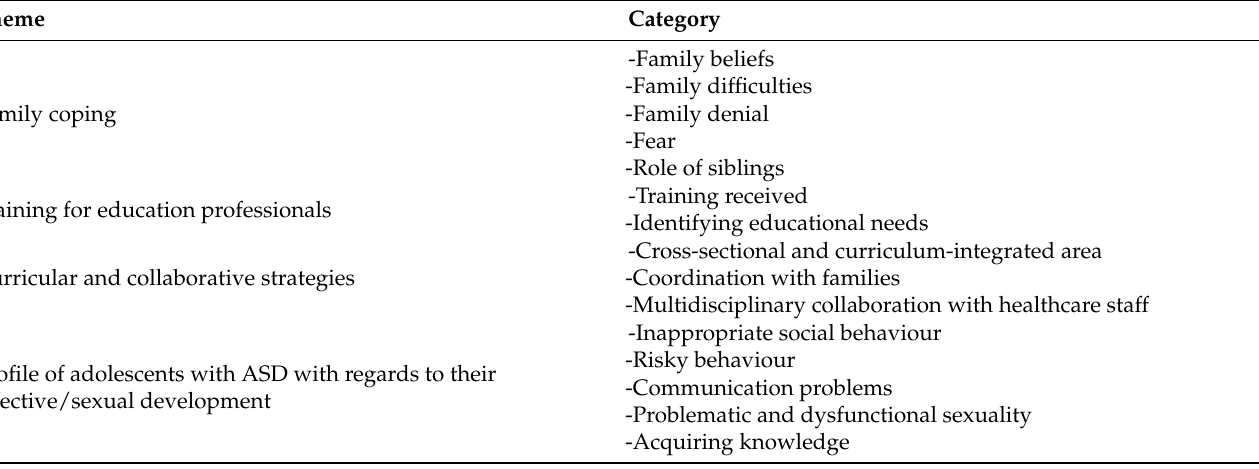
Table 3. Themes and categories identified from education